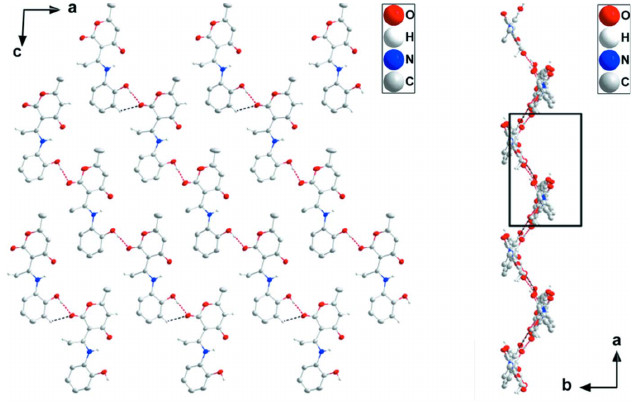
Figure 2 A portion of one layer viewed along the b -axis direction (left) and along the c -axis direction (right) with O—H (cid:2)(cid:2)(cid:2) O and C—H (cid:2)(cid:2)(cid:2) O hydrogen bonds depicted, respectively, by red and black dashed lines. Non- interacting H atoms are omitted for